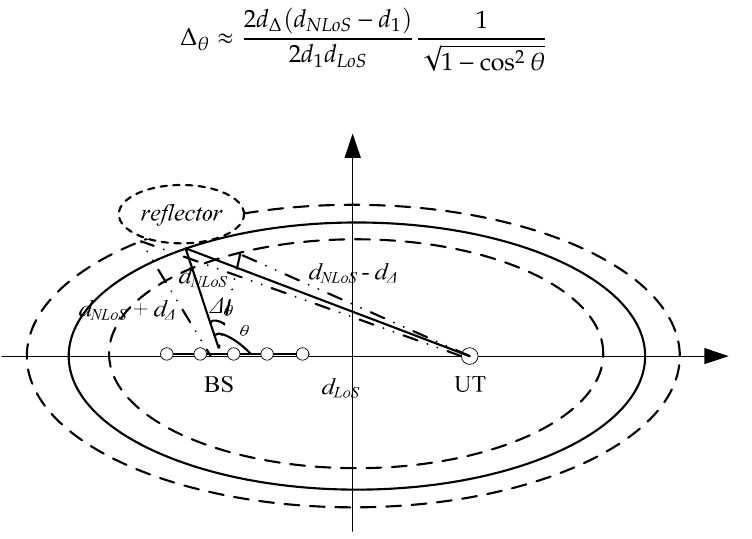
Figure 3. Ellipse geometry channel model for line of sight (LoS) and non-LoS (NLoS) transmission.